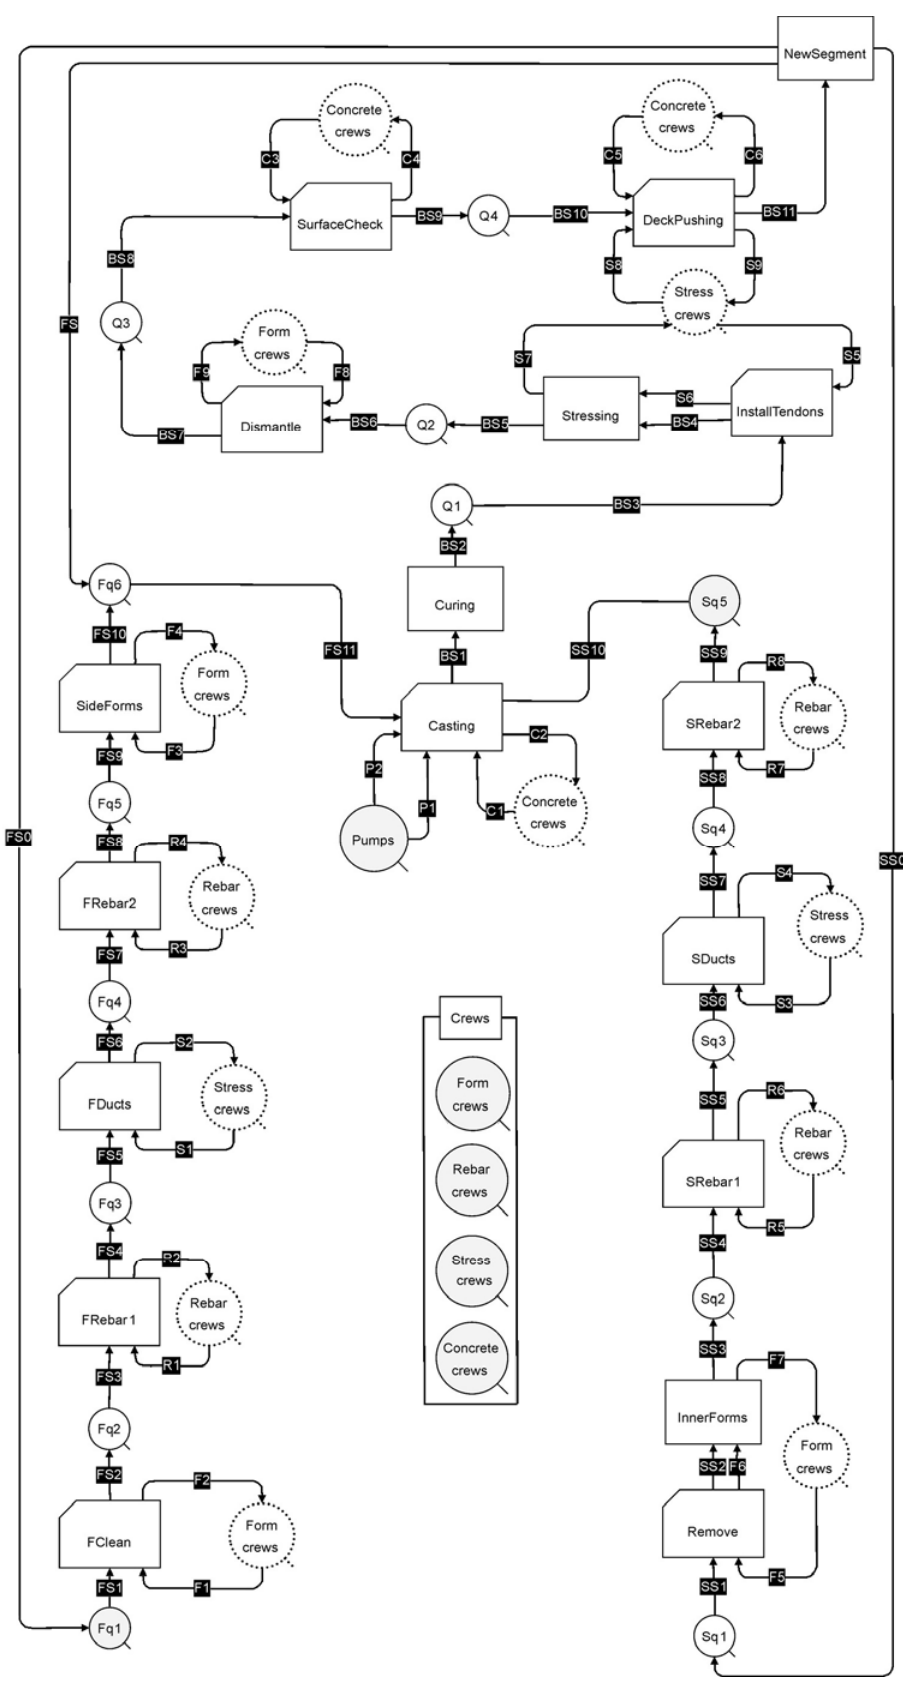
Fig 5 . Simulation network for multiple forms